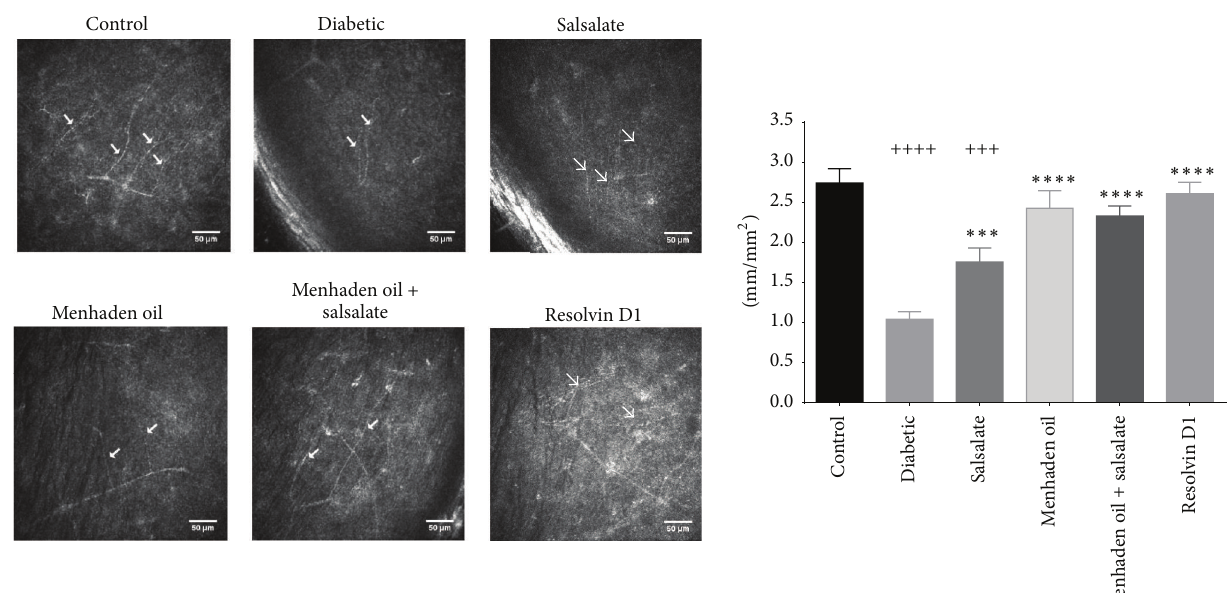
Figure 2: In vivo confocal microscopy was used to assess the effectiveness of drug treatment in diabetic mice. Subepithelial corneal innervation was scrutinized and images were analyzed for total nerve length. Arrows in the representative images indicate the location of subepithelial nerves. Data for innervation are presented as the mean ± SEM and shown in mm/mm 2 . The number of animals per group was the same as described in Table 3. +++ 𝑝 < 0.001 compared to control group, ++++ 𝑝 < 0.0001 compared to control group, ∗∗∗ 𝑝 < 0.001 compared to untreated diabetic group, and ∗∗∗∗ 𝑝 < 0.0001 compared to untreated diabetic group.